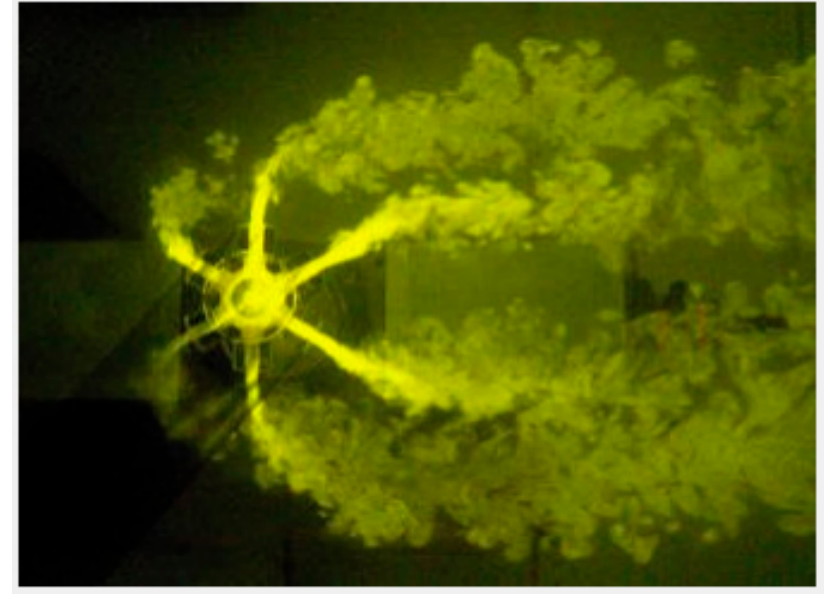
Figure 15. Rosette jet, top view (Source: Hong Kong University WATERMAN Educational Platform).